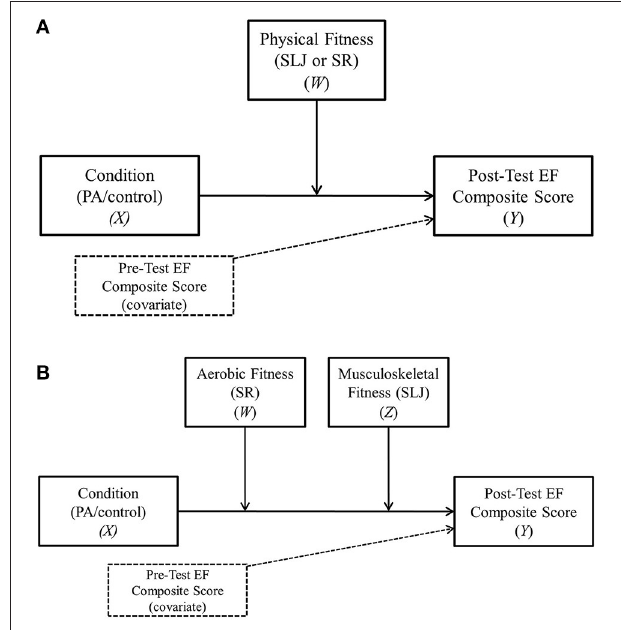
FIGURE 3 | (A) Acute physical activity—executive functioning single moderation model. (B) Acute physical activity—executive functioning additive moderation model. SLJ, standing long jump; SR, shuttle run; EF, executive functioning.